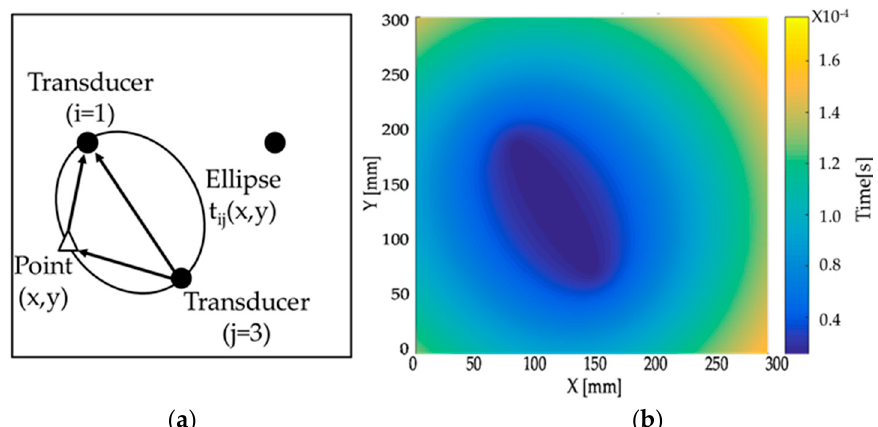
Figure 5. Schematic of the ellipse equation and the resulting map for all points in a 2D domain. ( a ) Equal travel times between a source and a sensor results in an ellipse; ( b ) Calculating the ellipse for all points in a domain leads to a map of travel time ellipses.